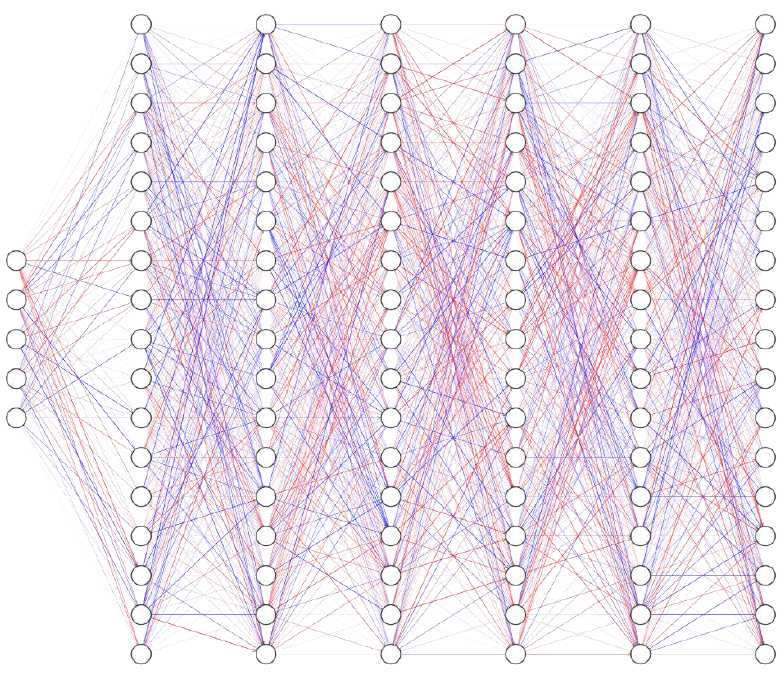
Figure 7. ANN predicts pressure values of non-critical nodes.